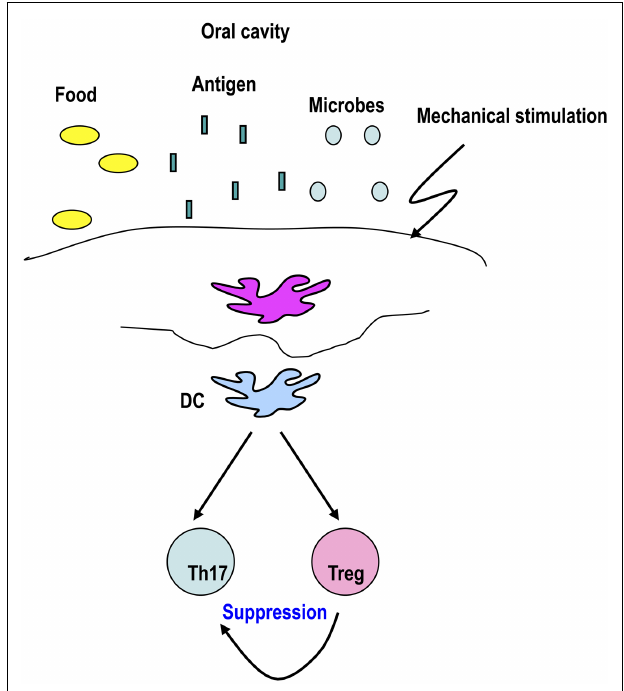
FIGURE 3 | DCs from the oral-cavity induce Foxp3 + T-regs to maintain tolerance .The oral cavity is exposed to several antigens and stimuli, including foods, microbes, inhaled antigens, and mechanical stimulation. These stimuli may be sensed by DCs that play a role in generating Foxp3 + T-regs to maintain tolerance in the oral